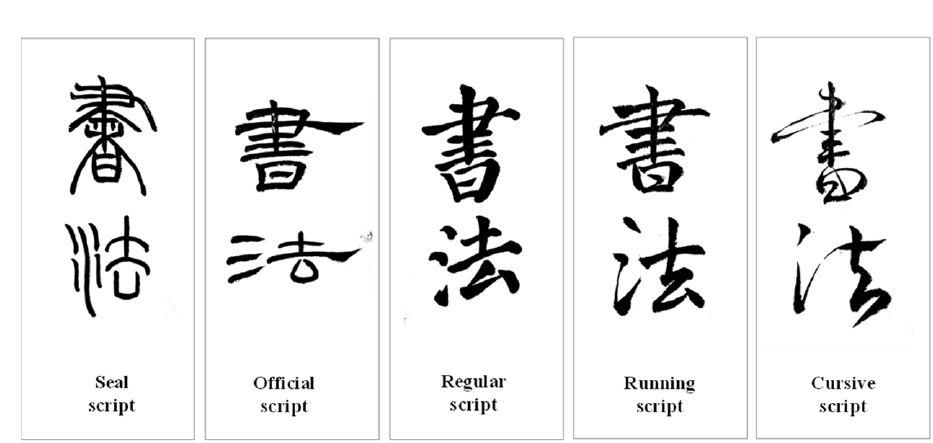
Figure A1. Five Major Calligraphy Scripts.